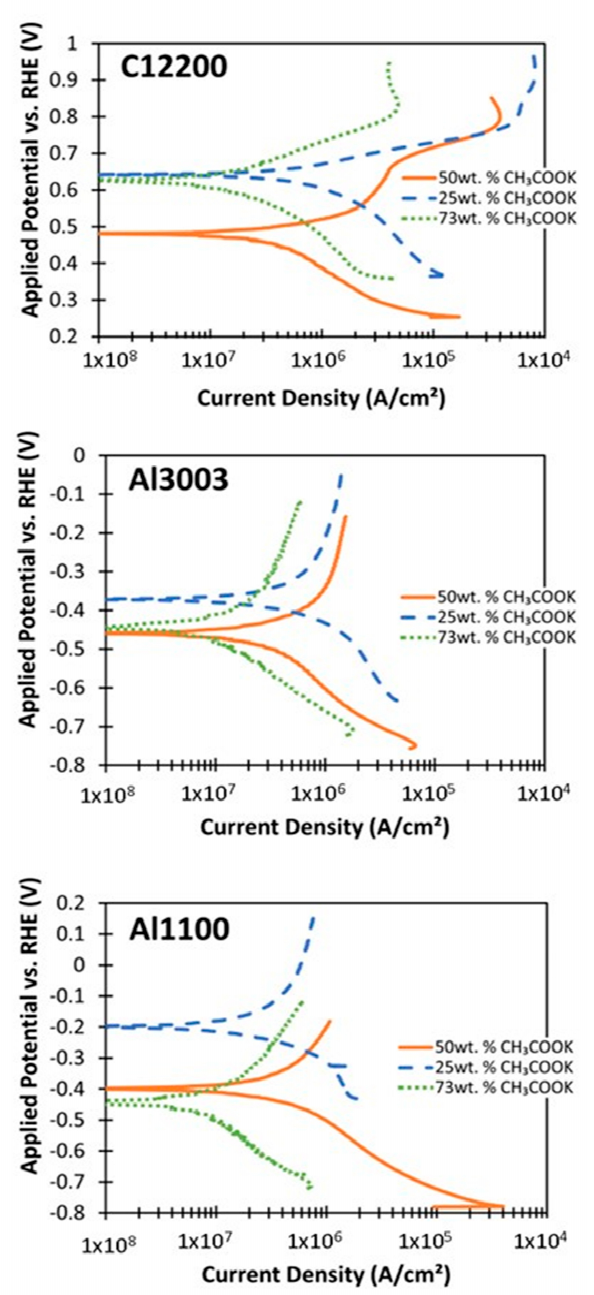
Figure 13. Potentiodynamic polarization curves for CH 3 COOK solutions of different concentrations. Experiments were performed at 23 °C.